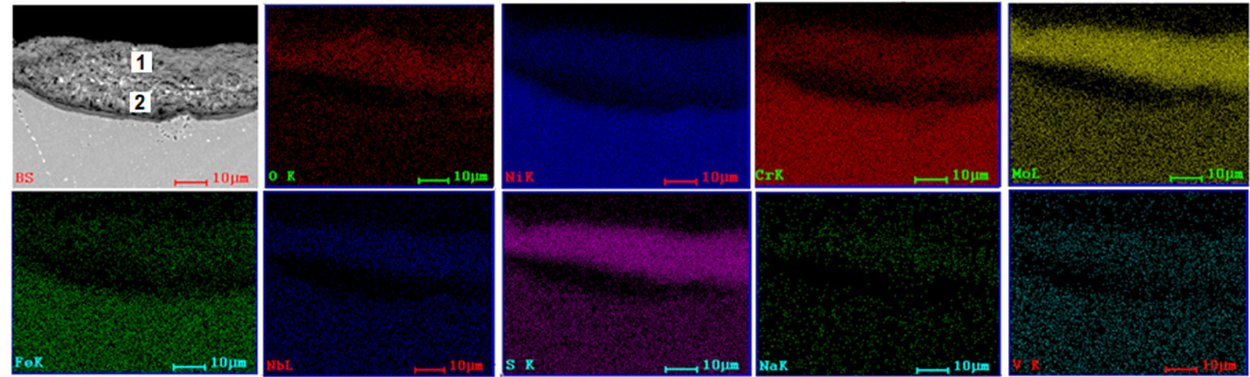
Figure 6. SEM image (BS) and EDS distribution maps of the elements corresponding to SEM image for cross section of AP (1000 °C, 8 h).